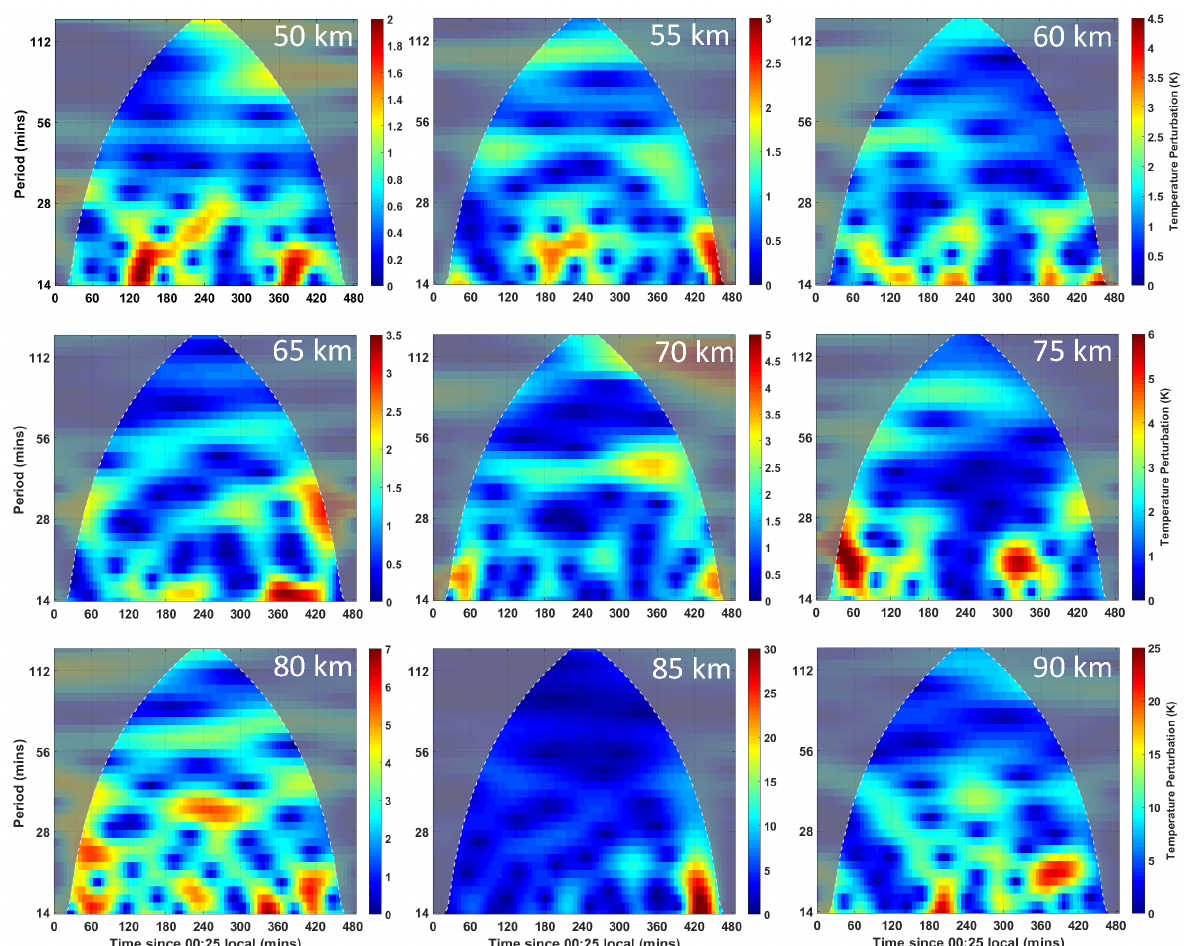
Figure 10. Continuous Morlet wavelet transform of the lidar temperature perturbations on the night of D+0. Scalograms are given at nine altitudes for wave period as a function of measurement